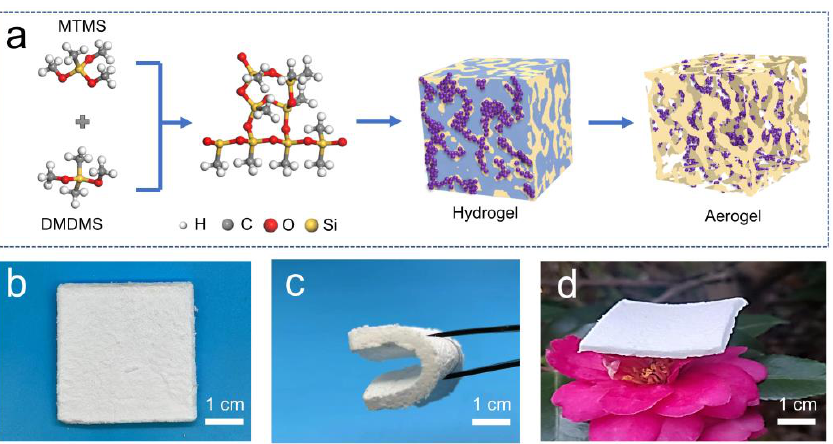
Figure 1. ( a ) Illustration of the synthetic approach to the MTMS–DMDMS aerogel (MDA); ( b )-( d ) photo images of an MDA, a blended DMA, and an MDA standing on a flower, respectively.